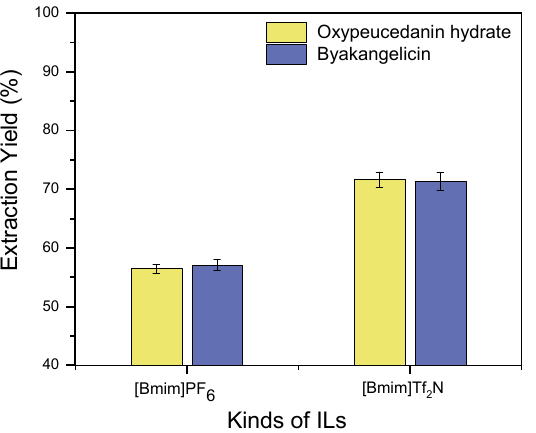
Figure 2. Effect of ionic liquids (ILs) on the extraction of oxypeucedanin hydrate and